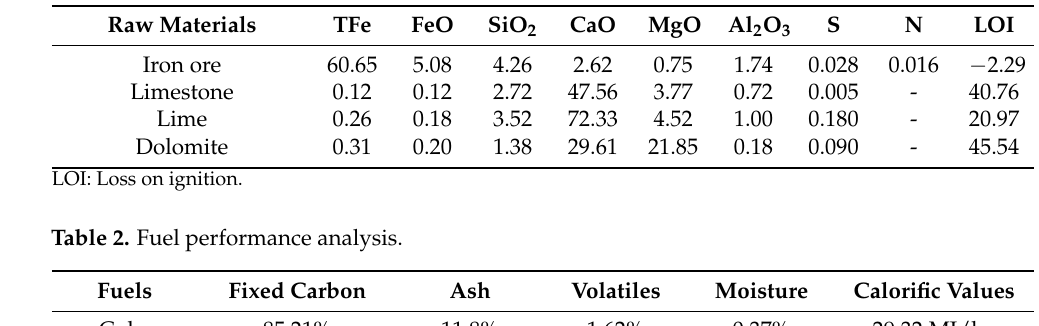
Table 1. Sintering raw material composition (mass fraction/%).